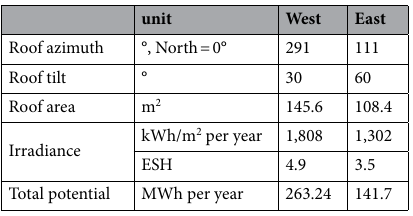
Table 6. Irradiance potential on Ontowiryo mosque rooftop.